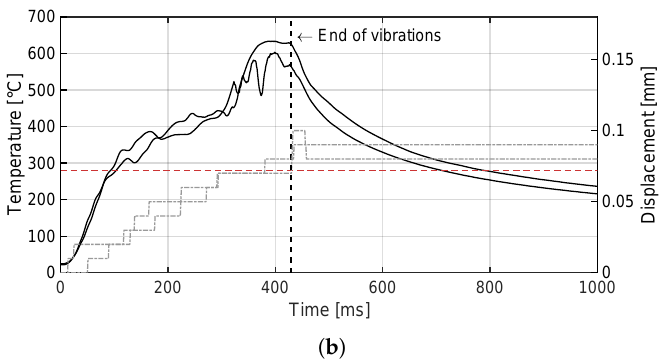
Figure 7. Interface temperature (black curves) and measured downward vertical displacement (grey curves) of the sonotrode for static welds on ( a ) 15 mm wide and ( b ) 220 mm wide adherends. It should be noted that one of the two welds in ( b ) was made 40 mm to the left from the intended location in Figure 4a. The red dashed line indicates the melting temperature of PPS ( T m , 280 ◦ C) as experimentally determined by DSC analysis.